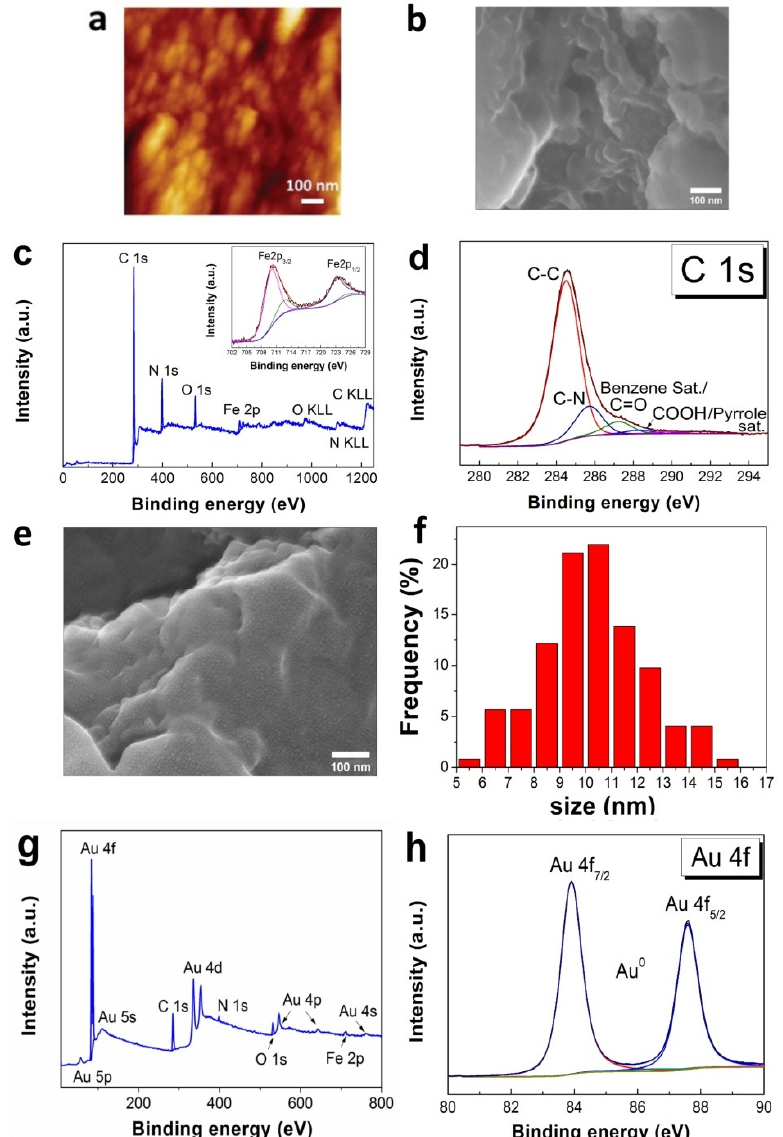
Figure 1. AFM image of a bare GCE ( a ); SEM image of the FePc(tBu) 4 /GCE ( b ); XPS spectrum of the FePc(tBu) 4 /GCE with Fe 2p ( c ); fitting of the C 1s spectra ( d ); SEM image of the Au/FePc(tBu) 4 /GCE ( e ) with AuNPs size distribution ( f ); XPS spectrum of the Au/FePc(tBu) 4 /GCE ( g ); and fitting of the Au 4f spectra ( h ).